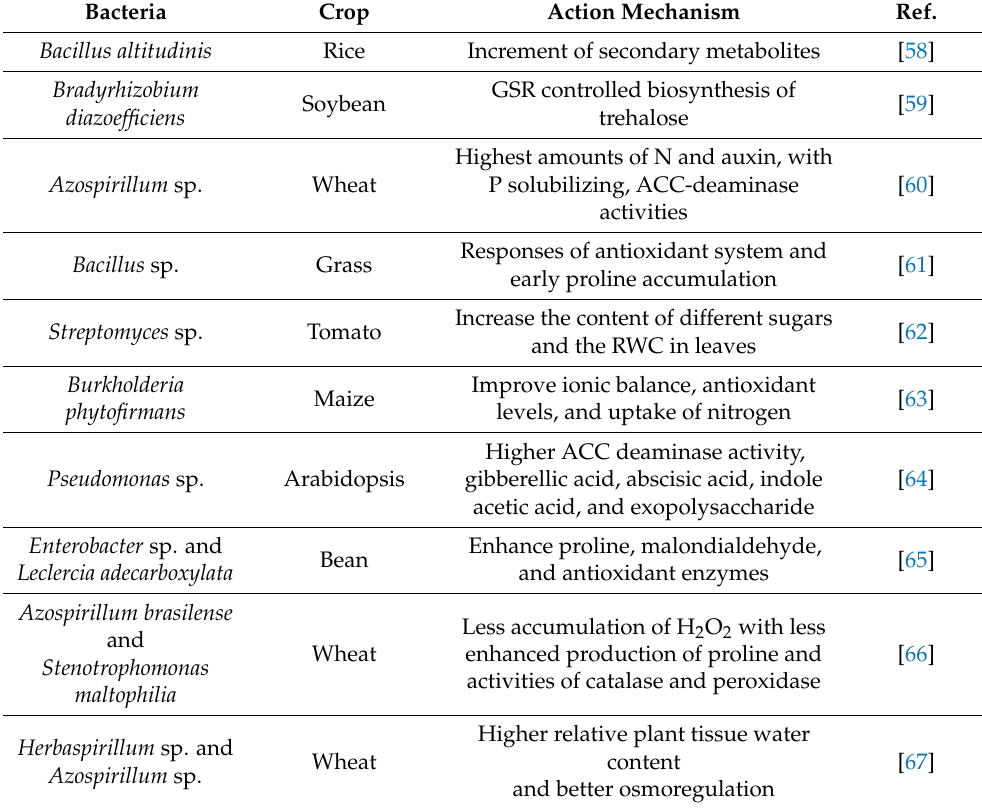
Table 1. General mechanisms of drought resistance and bacterial